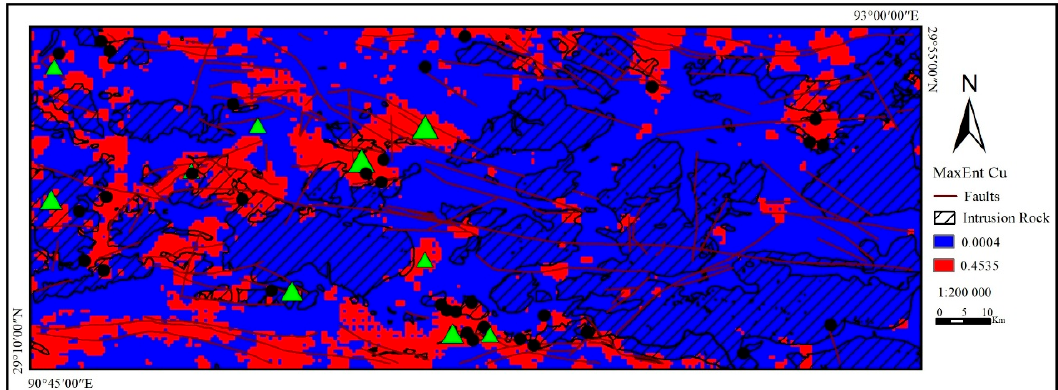
Figure 12. Binary copper perspective map of the Mila Mountain generated from MaxEnt model.